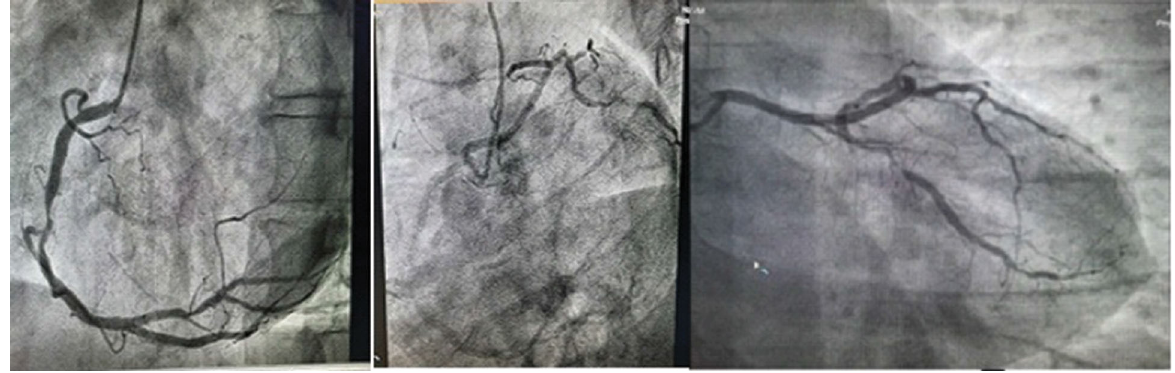
Figure 1: Coronary angiogram